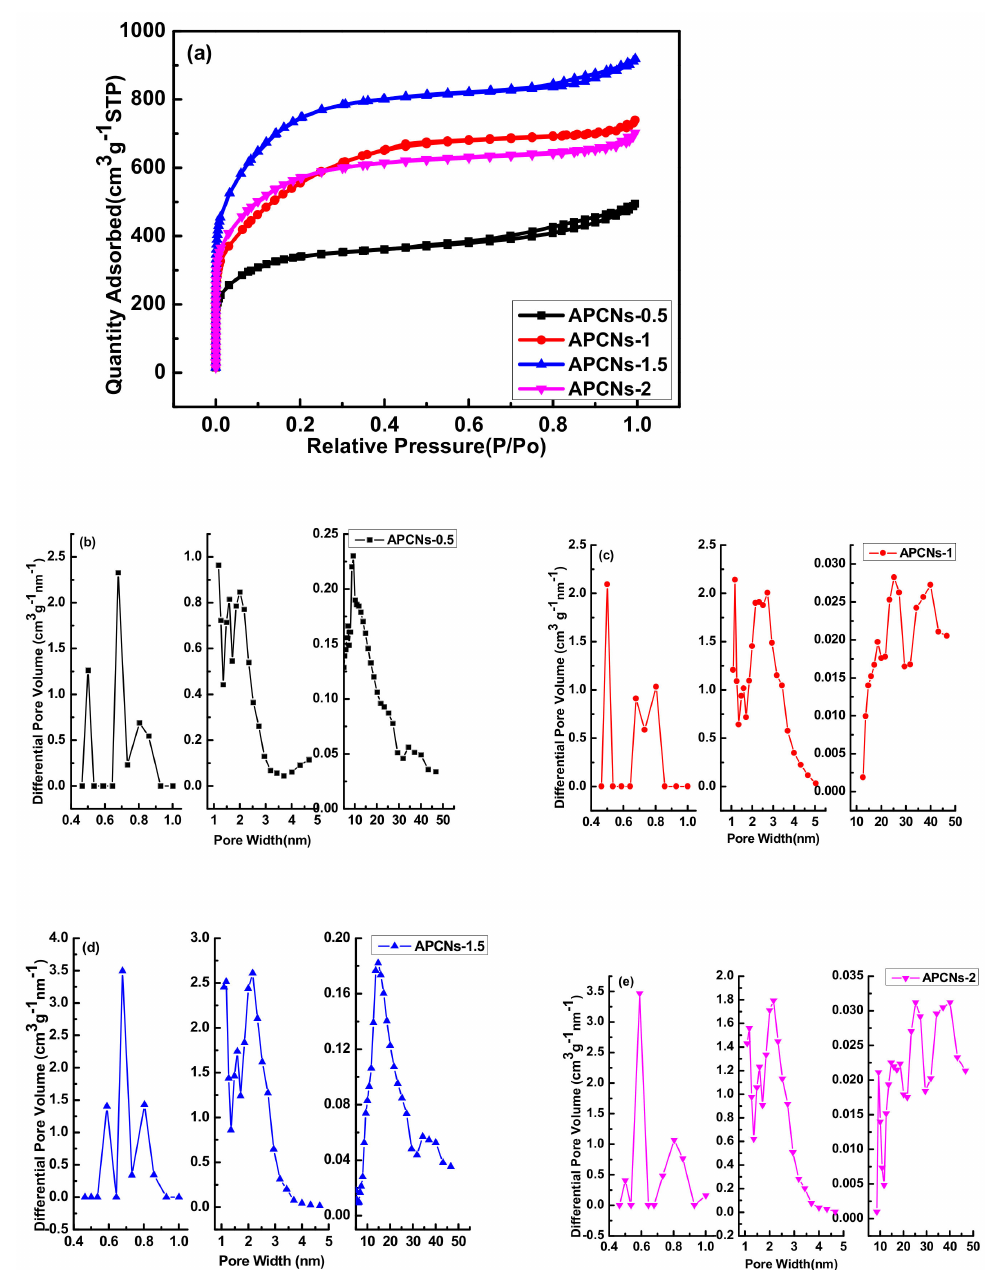
Figure 10. The adsorption isotherm curve and pore size distribution diagram for different activation holding time in the one-step activation method: ( a ) adsorption isotherm curve; pore size distribution for: ( b ) APCNs-0.5; ( c ) APCNs-1; ( d ) APCNs-1.5; ( e )